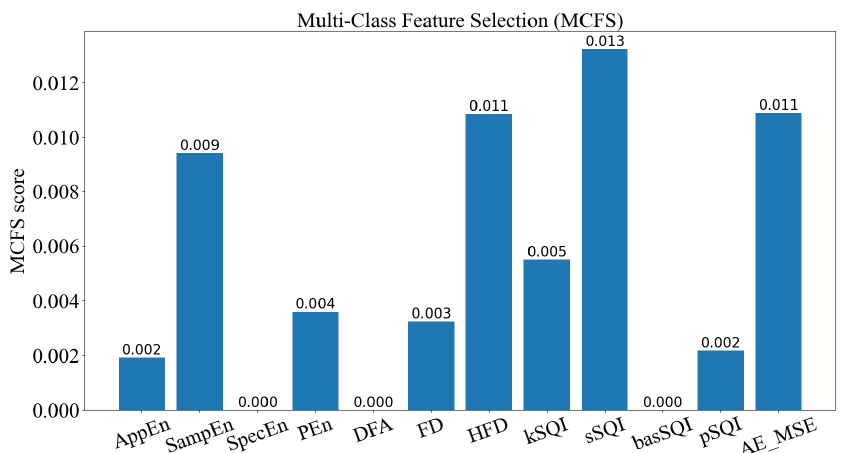
Figure 6. MCFS score for each feature. A feature with a larger score means that this feature plays a more significant role in the classification task. Relatively, five features, including SampEn, HFD, kSQI, sSQI, and AE_MSE, have higher MCFS score than the other